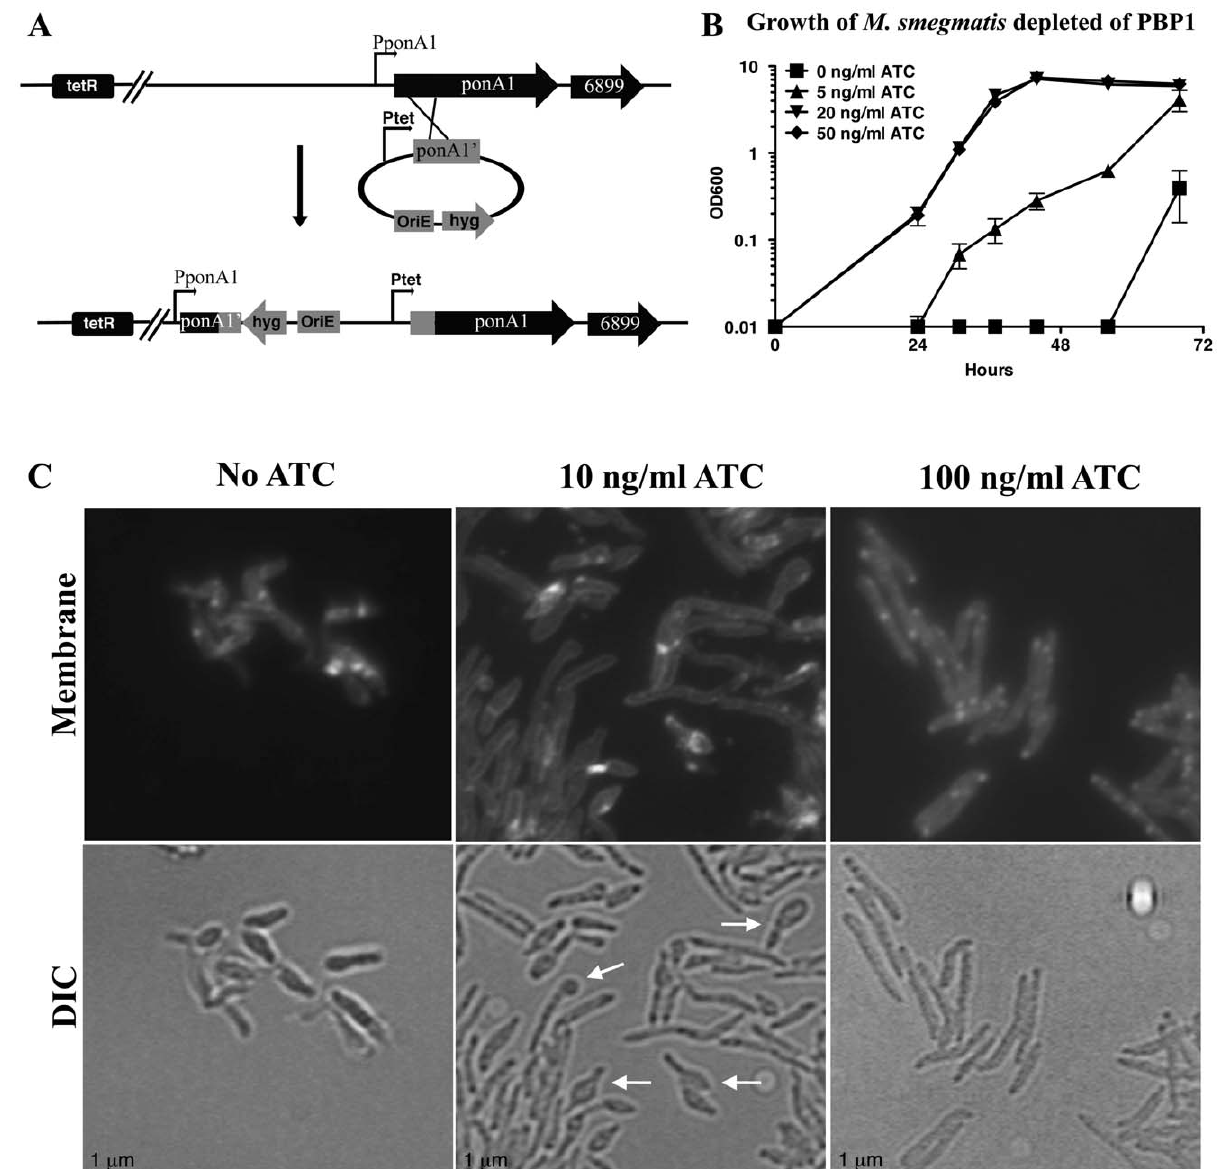
Figure 5. Depletion of PBP1 blocks cell division. (A) Diagram showing the strategy used to replace the native promoter of the ponA1 operon (PponA1) in M. smegmatis with a tetracycline-inducible promoter (Ptet) through homologous recombination (strategy and diagram adapted from [12]). OriE: E. coli origin of replication. (B) PBP1 ( ponA1 ) depletion strain of M. smegmatis was grown with inducer (ATC=anhydrotetracycline), then inoculated into media with decreasing amounts of inducer and followed by OD 600 over time. Data are represented as mean + / 2 standard deviation. (C) Micrographs of M. smegmatis PBP1 ( ponA1 ) depletion strain with membranes imaged by staining with TMA-DPH. Bacteria were grown with no anhydrotetracycline inducer (No ATC), 10, or 100 ng/ml ATC. Bacteria grown with 100 ng/ml ATC grew as wildtype, while No ATC and 10 ng/ml ATC grew slowly, with bulbous poles and round-shaped regions (indicated by white arrows). Bacteria were visualized with a 100 6 objective.